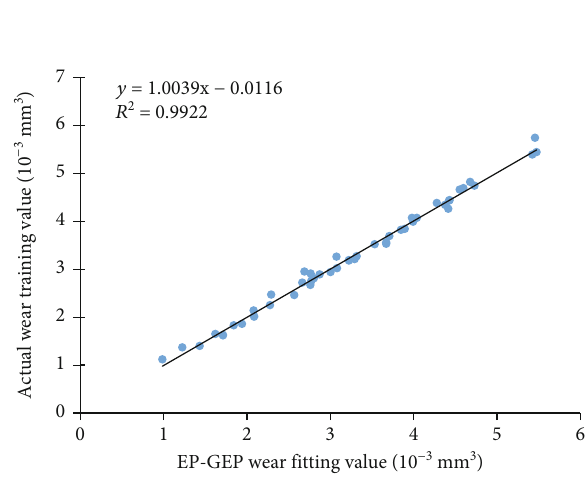
Figure 6: Comparison between wear amount of training dataset and EP-GEP fi tting value.